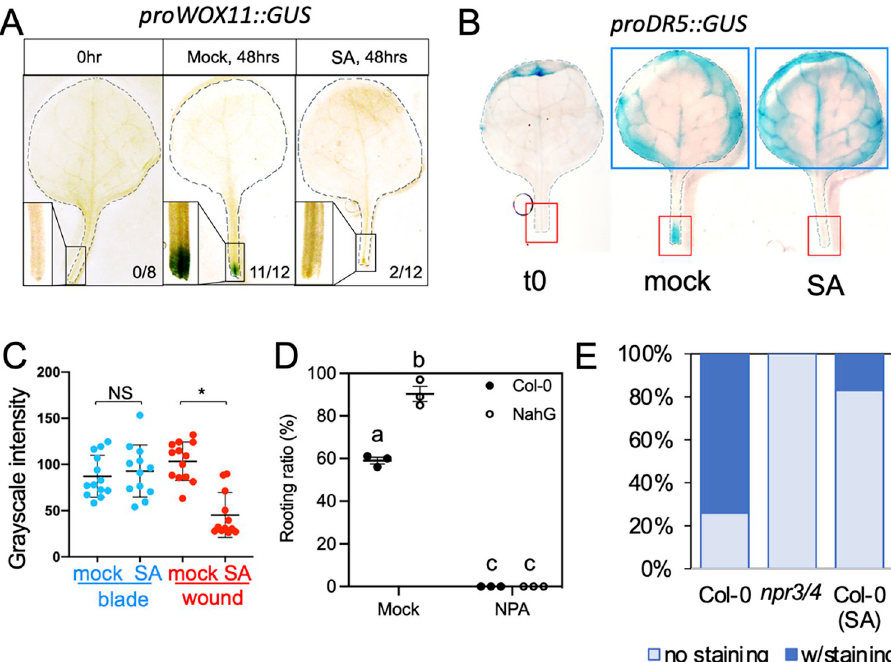
Fig 4. SA inhibited auxin transportation to the cutting site. (A) Expression pattern of proWOX11 :: GUS in explants treated with SA or mock. Note the lack of staining at the cut site of SA treated samples. Samples were stained at 2 DAC. (B) SA treatment compromised the activation of auxin reporter, proDR5 :: GUS , at the cut site (red box), but not in distal tissue (blue box). Cutting was made at the base of petiole to distinguish the staining of DR5 at the wound site versus distal sites. T0 sample was stained on an intact plant and cut after staining. Mock and SA samples were stained at 1 DAC. (C) Quantification of GUS staining showed that SA treatment specifically reduced staining at the wound site but not in the distal tissue. Each dot represents an individual leaf sample. � : p < 0.01 using student t -test. Y axis represents gray scale intensity. BTH, an SA analogue, was used in the SA treatment (A, B and C) at a concentration of 300 μ M. (D) Rooting ratio in Col-0 and NahG after NPA treatment. NPA treatment (1 μ M) abolished the high rooting phenotype in NahG. Different letters indicate significant difference using one way ANOVA. (E) Ratio of explants with proDR5::GUS activity at the cutting site. npr3/4 mutation and SA treatment reduced the staining at cutting sites. Around 40 explants were analyzed for each